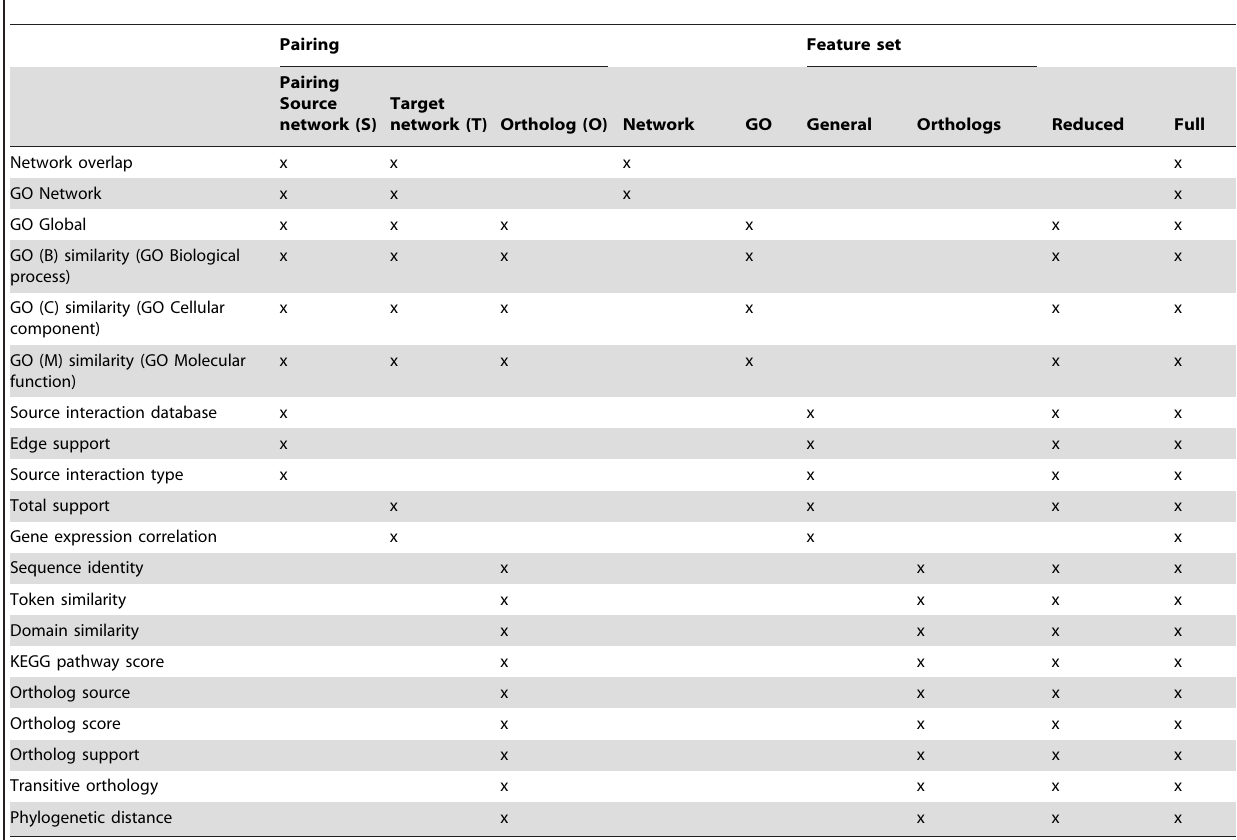
Table 2. Feature set